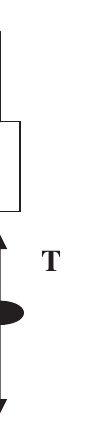
FIG. 4. Object suspended in an